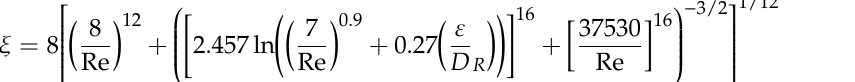
Figure 9. Plot of ln(Nu A /Pr 0.4 ) as a function of ln(Re) for the experimental data.